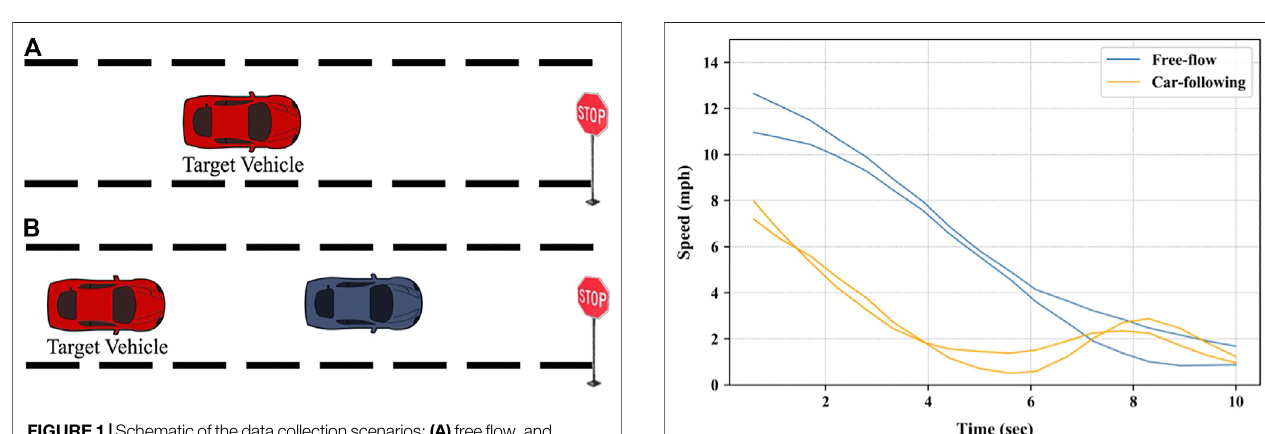
FIGURE1| Schematicofthedatacollectionscenarios: (A) free fl ow,and (B) car-following conditions.